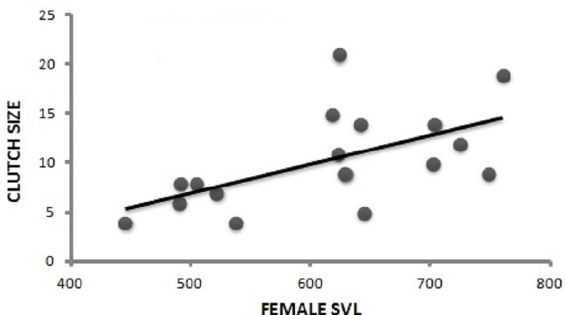
Figure 3 - linear regression between clutch size and SVl of females (in mm) of Erythrolamprus miliaris from the state of Rio de Janeiro.